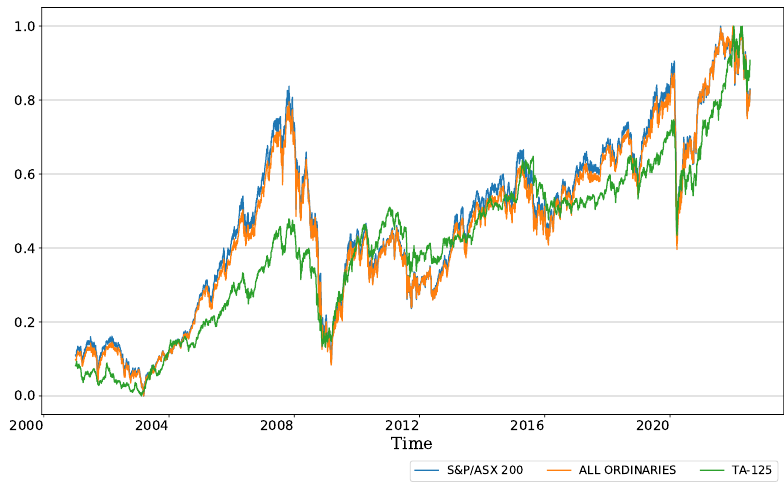
Figure A5. Evolutionary dynamics of other financial market